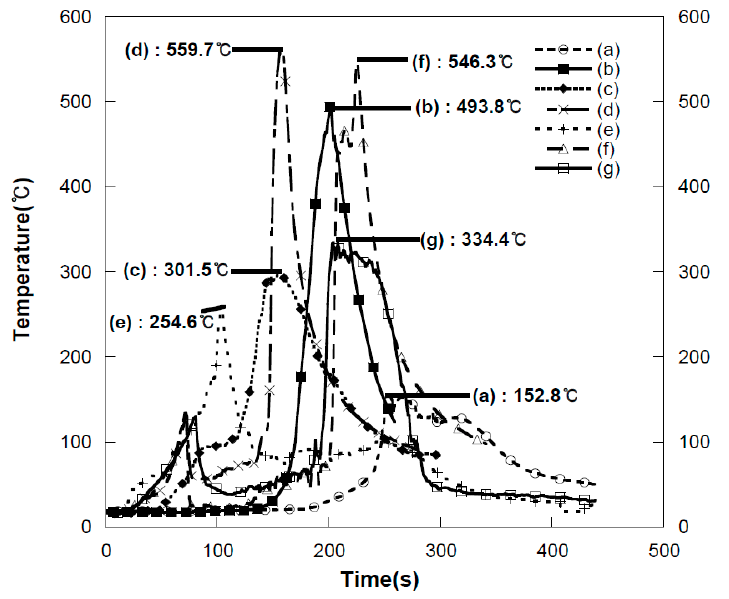
Figure 9. Ceiling heat air current temperature curves according to the ignition source in the sofa model fire tests.